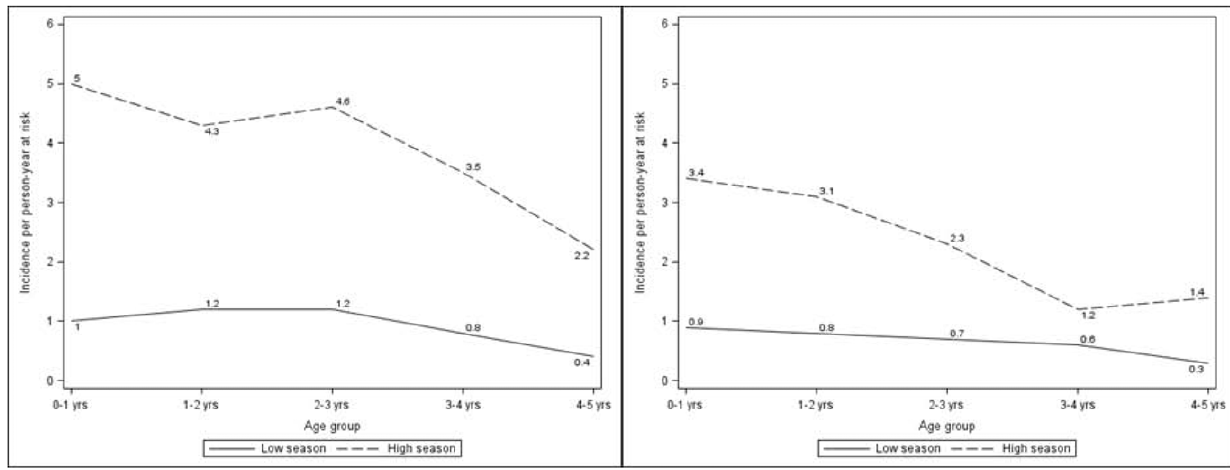
Figure 1. Age-specific malaria incidence according to the season. a. Seasonal variation in age-specific clinical malaria incidence evaluated by active surveillance over one year. b. Seasonal variation in age-specific clinical malaria incidence evaluated by passive surveillance over one